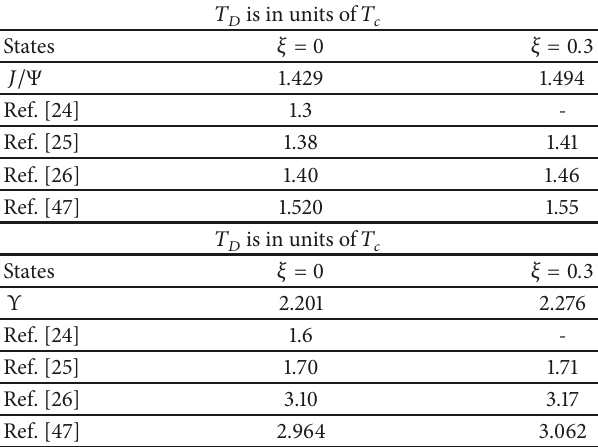
Table 1: Dissociation temperature (𝑇 𝐷 ) at 𝜇 𝑏 = 0 and 𝑁 = 3